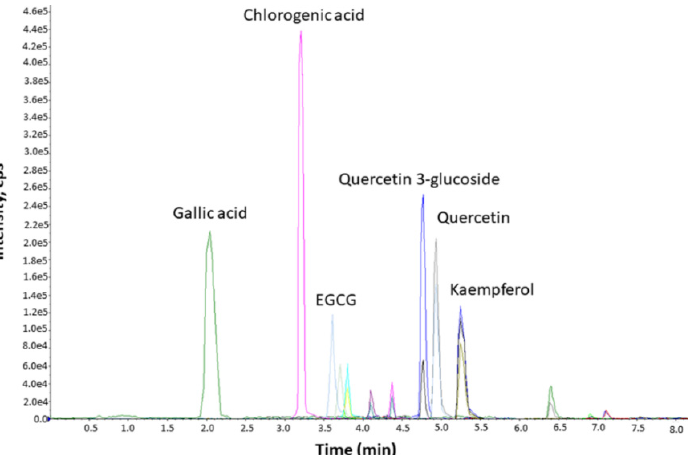
Figure 1. Chemical composition of CsPE. The ethanolic extract was analyzed by UHPLC. Chroma- tograms of the main compounds identified in CsPE were obtained by ion-trap tandem mass spec- trometry (UHPLC-QATRAP) using an ACE Excel 2 C18-PFP